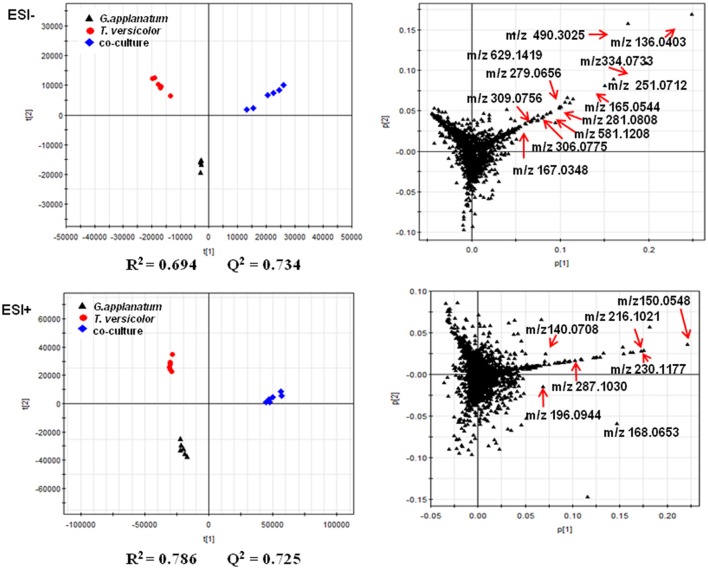
PCA of metabolomics data of co-culture and their corresponding mono-cultures on day 18 is shown. The score and loading plots of the data analyzed by LC-QTOF-MS in the negative mode (2287 features) and positive mode (2076 features), respectively. The parameters (R2 and Q2) of the score plots demonstrated the discriminative ability of this model. The scattered dots labeled with m/z were representative features mentioned in the Results section.